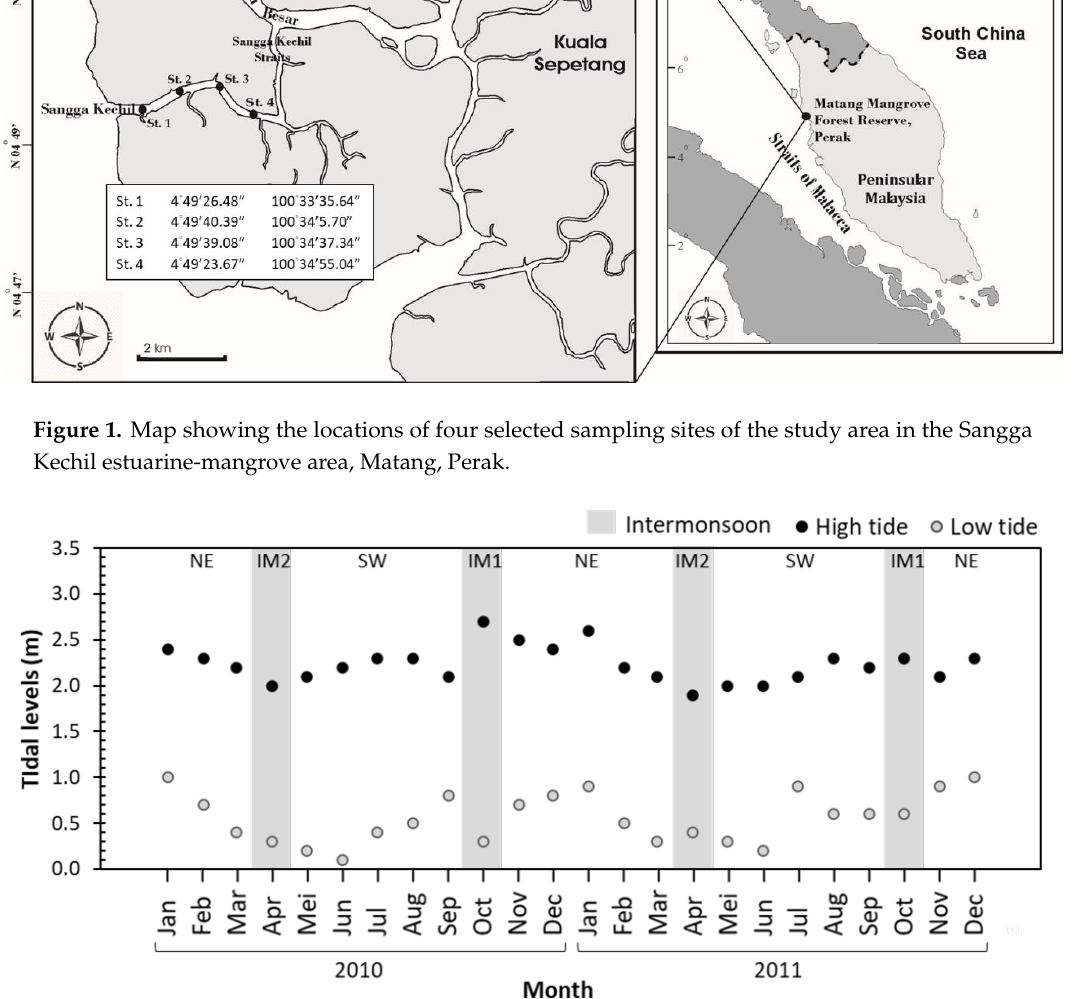
Figure 2. Tidal levels (m) at Sangga Kechil estuarine-mangrove from 2010 to 2011. NE, northeast; SW, southwest; IM1, intermonsoon (transition from dry to wet season); IM2, intermonsoon (transition from wet to dry season).